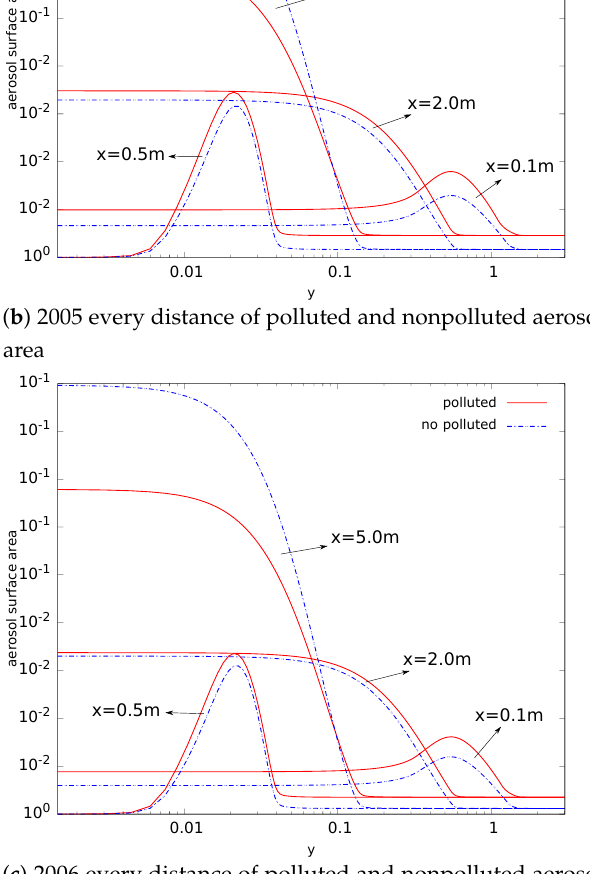
Figure 6. Status of aerosol surface area over three different